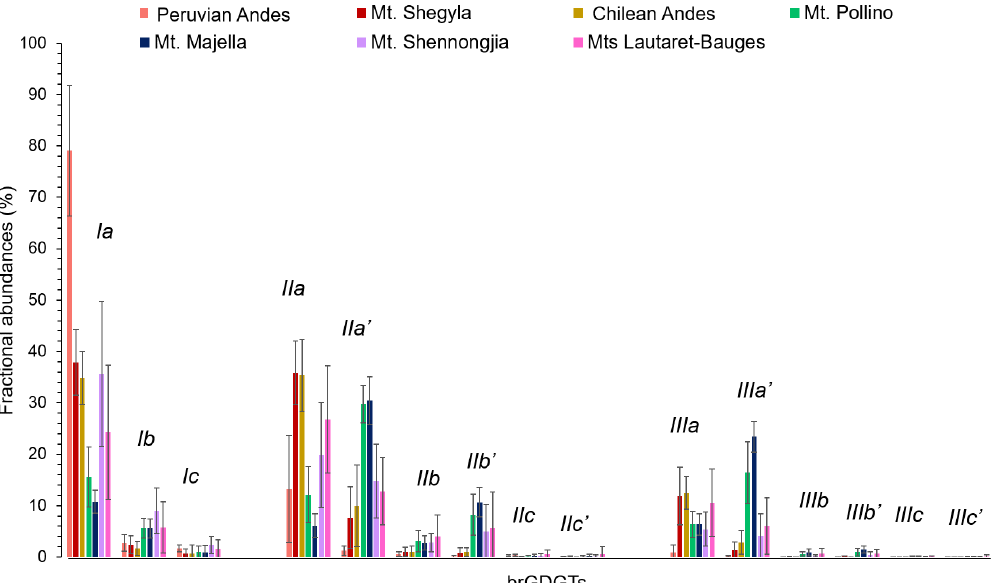
Figure 2. Average distribution of 5- and 6-methyl brGDGTs, along Mt. Shegyla, Mt. Pollino Majella, Lautaret-Bauges, the Peruvian Andes and the Chilean Andes. Data from Mt. Majella were taken from Huguet et al. (2019). Data from Mt. Shennongjia were taken from Yang et al. (2015). Data from Mt. Bauges and Mt. Lautaret-Galibier were taken from Véquaud et al.